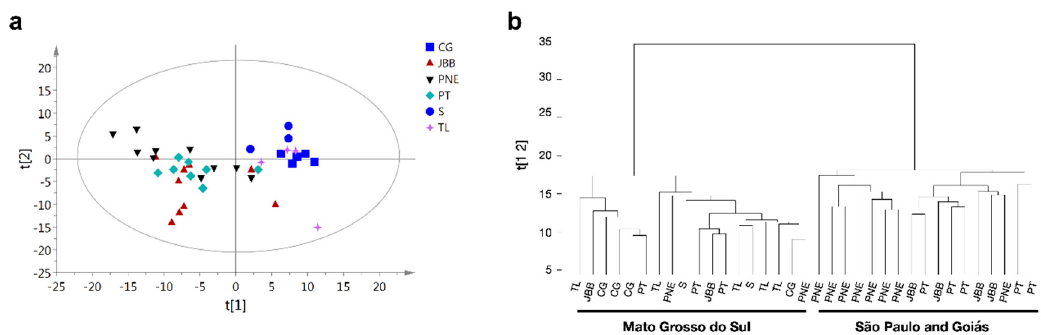
Figure 4. Multivariate data analysis of the AFLP markers data of Myrcia bella samples from different regions of Cerrado. ( a ) PCA score plot derived from 40 samples. ( b ) HCA plot derived from the generated PCA score plot. Both PCA and HCA highlighted the presence of two main genotype clusters. List of abbreviations: CG = Campo Grande; S = Selvíria; TL = Três Lagoas; PNE = Parque Nacional das Emas; PT = Pratânia; JBB = Jardim Botânico de Bauru.